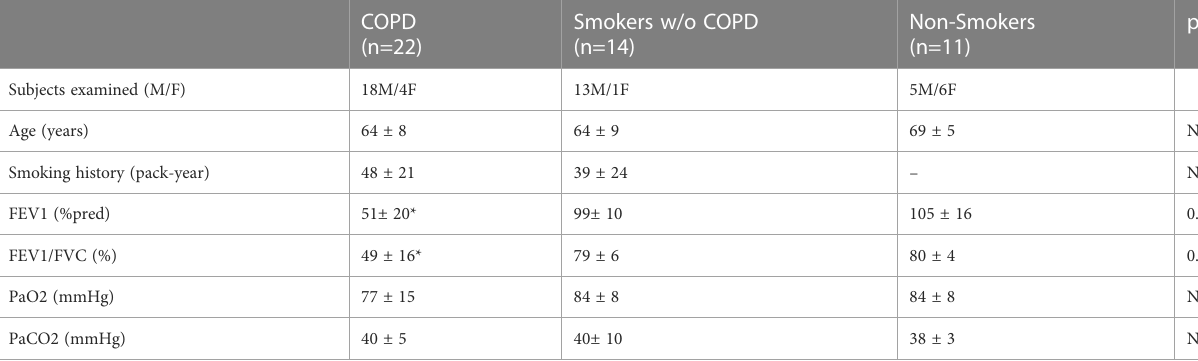
TABLE 1 Clinical characteristics of the subjects in the study